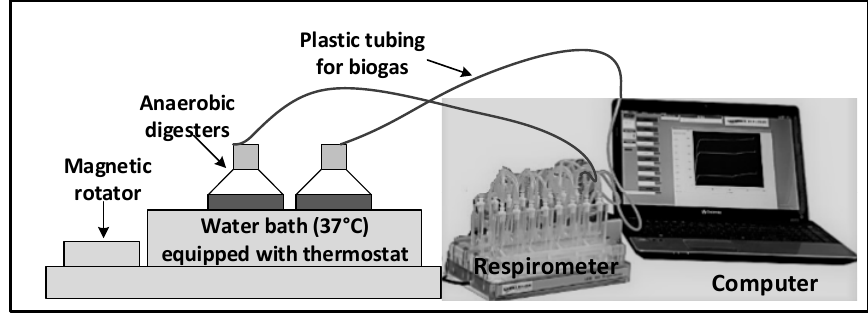
Figure 5. Anaerobic degradability assay.